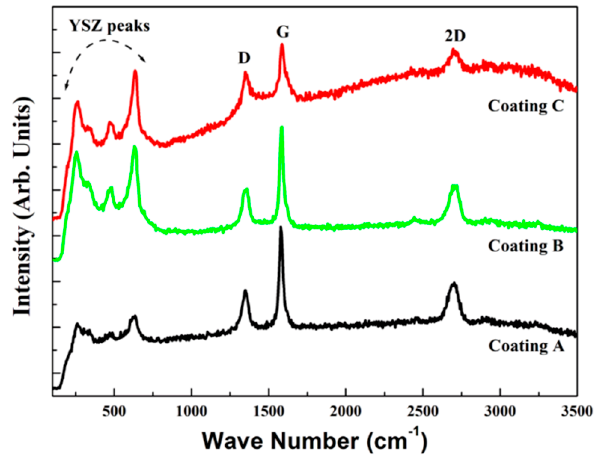
Figure 3. The Raman spectra of the 8 wt.% yttria-stabilized-zirconia-graphene (8YSZ-graphene) composite coatings .